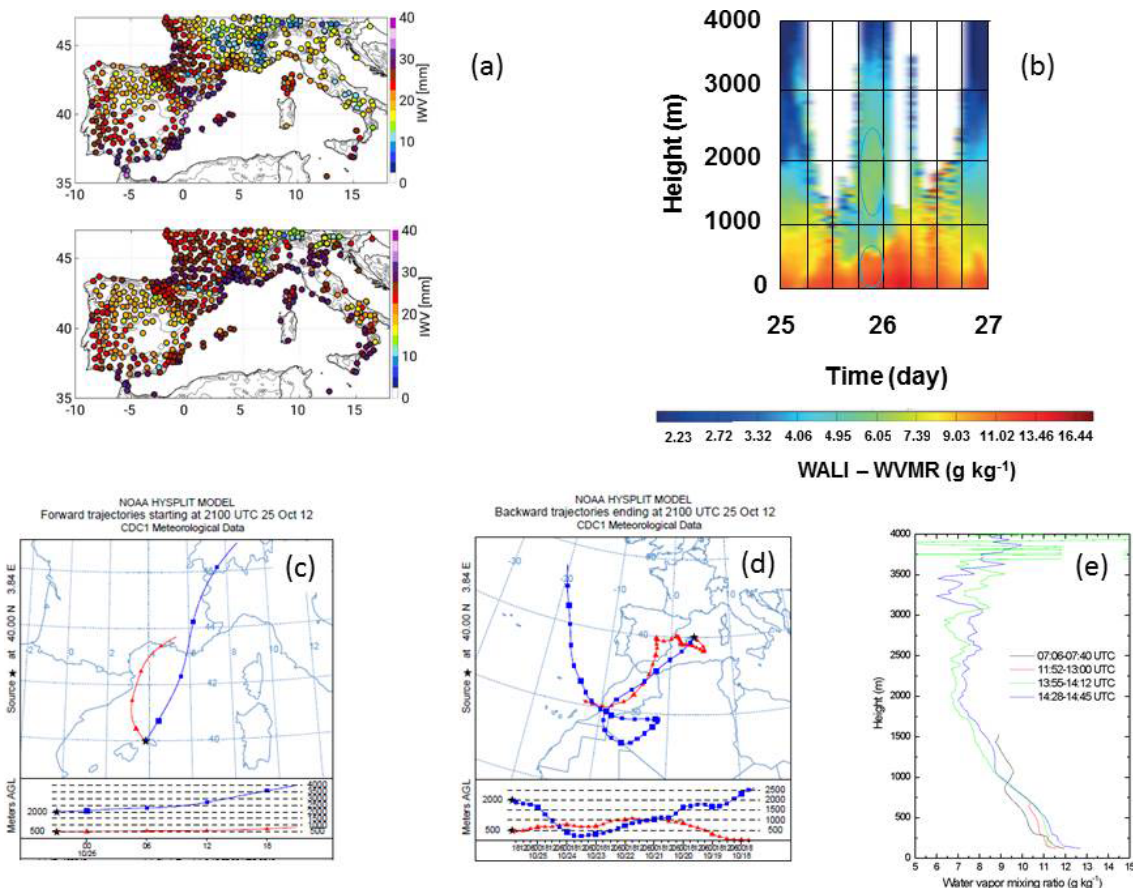
Figure 3. (a) Spatial distribution of 24h averaged GPS-derived IWV (mm) on 25 (a, b) and 26 (c–e) October 2012. (b) Time evolution of the water vapor mixing ratio (gkg − 1 ) as measured by the ground-based lidar WALI in Menorca over the 48h period from 00:00UTC on 25 October 2012 to 00:00UTC on 27 October 2012. (c) 24h forward-trajectory analysis from HYSPLIT starting in Ciutadella (Menorca) at 21:00UTC on 25 October 2012 and ending at 21:00UTC on 26 October 2012. (d) 200h back-trajectory analysis from HYSPLIT ending in Ciutadella (Menorca) at 21:00UTC on 25 October 2012. (e) Vertical profiles of the water vapor mixing ratio (gkg − 1 ) as measured by the ground-based lidar BASIL in Candillargues at different times on 26 October